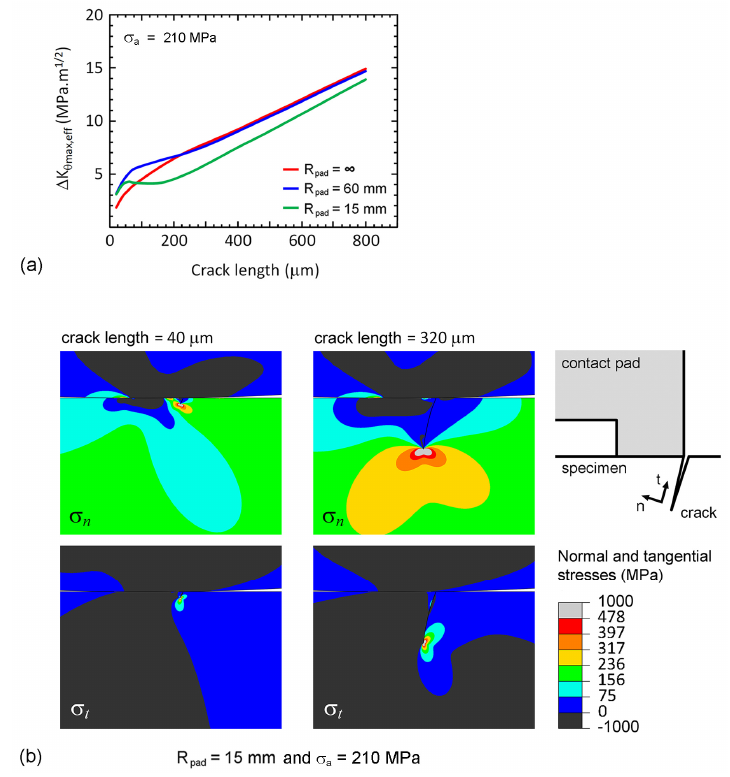
Figure 16. Fretting fatigue at stress amplitude of 210 MPa: ( a ) relationships between the effective stress intensity factor range and crack length; and ( b ) distributions of normal and tangential stresses on fretting fatigue specimen with 15-mm radius of contact pad at the maximum σ B .